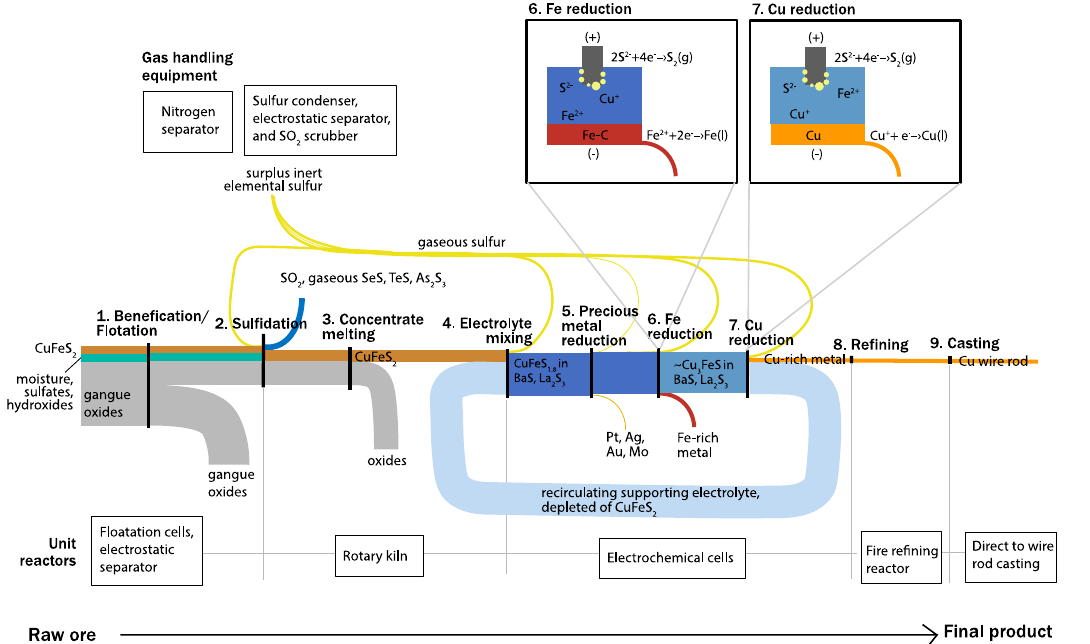
Figure 7. Schematic process flow for treating chalcopyrite, from raw ore to copper wire rod. Each vertical black line is a process step with the material inputs represented by horizontal flows on the left-hand side, and process outputs on the right. The unit reactors for each process step are shown in the boxes below, with the gas handling equipment required shown above the diagram. Schematics of the iron and copper reduction cells and the half-cell reactions are shown above. The width of flows drawn are relative, not to scale.